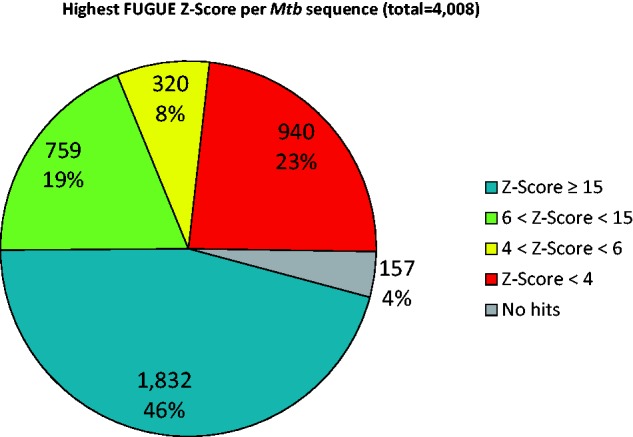
Distribution of the best FUGUE Z-Scores for all sequences of Mtb proteome. Blue (Z-Score ≥ 15), green (6 < Z-Score < 15) and yellow (4 < Z-Score < 6) correspond to very high, high and reasonable confidence matches, respectively, whereas red indicates non-significant hits.